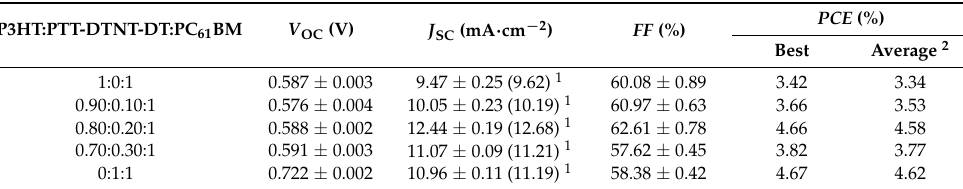
Figure 3. ( a ) Current-voltage curves of the binary and ternary devices; ( b ) the corresponding EQE spectra of the OPVs. Table 1. Photovoltaic parameters of the OPVs.